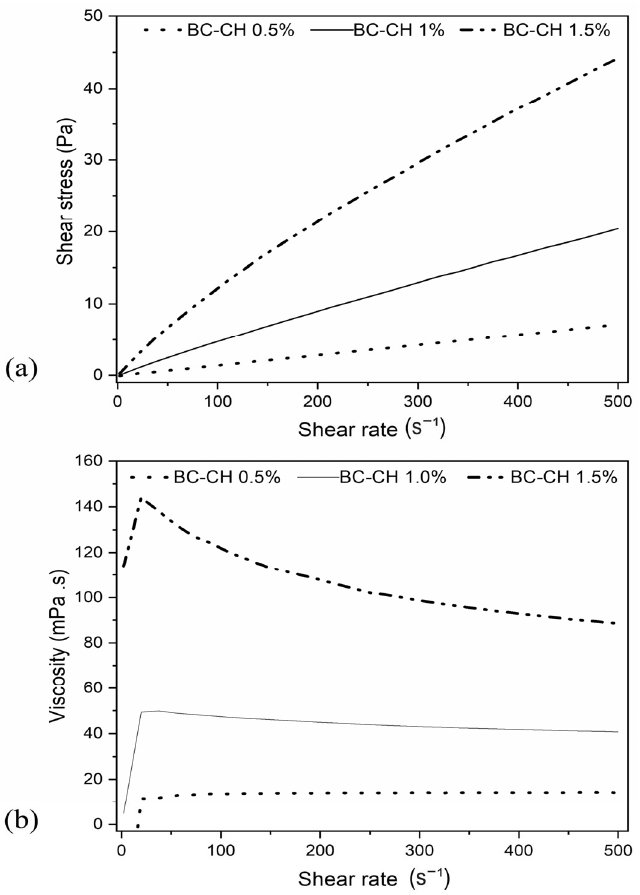
Figure 2. ( a ) Flow curve, and ( b ) viscosity curve of CFS prepared with different concentrations of chitosan.